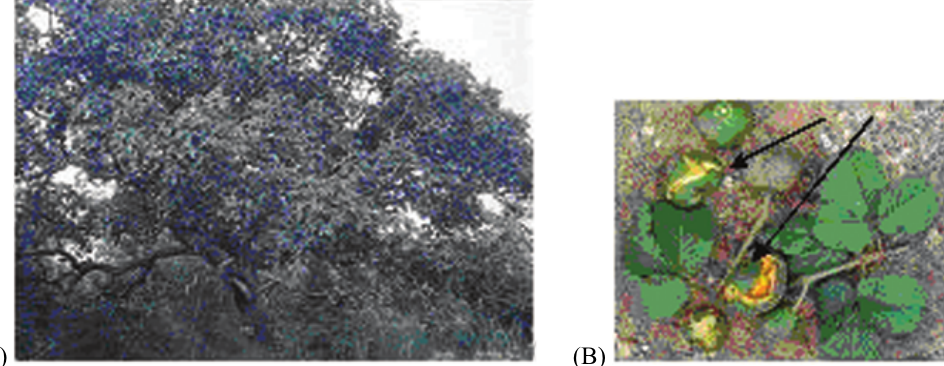
Fig. 2 – Pequi tree ( Caryocar brasiliense ). (A) Adult plant. (B) Details of the